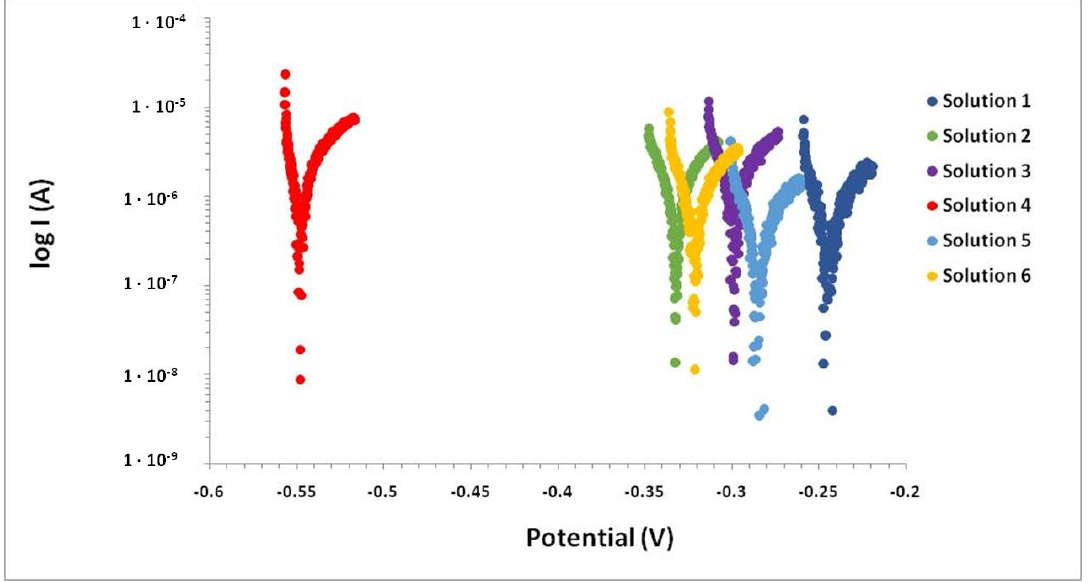
Figure 2. Polarization resistance curves of zinc wires in solution cells after 35 days of manufacture.